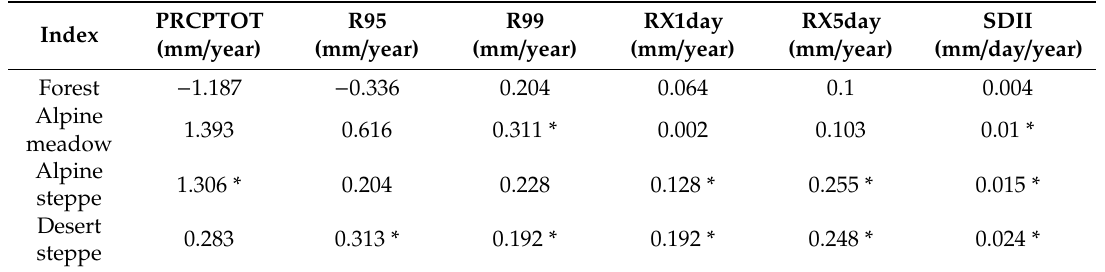
Table 6. Precipitation linear trend and significance in di ff erent